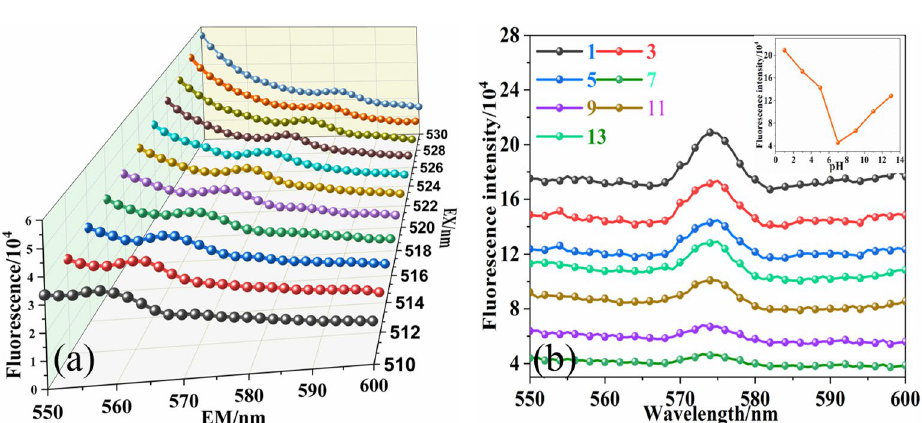
Figure 5. Effect of the external environment on the fluorescent properties of CNF-3. ( a ) Excitation wavelength, ( b ) different pH. Inset: The trend of the change in fluorescence intensity at different